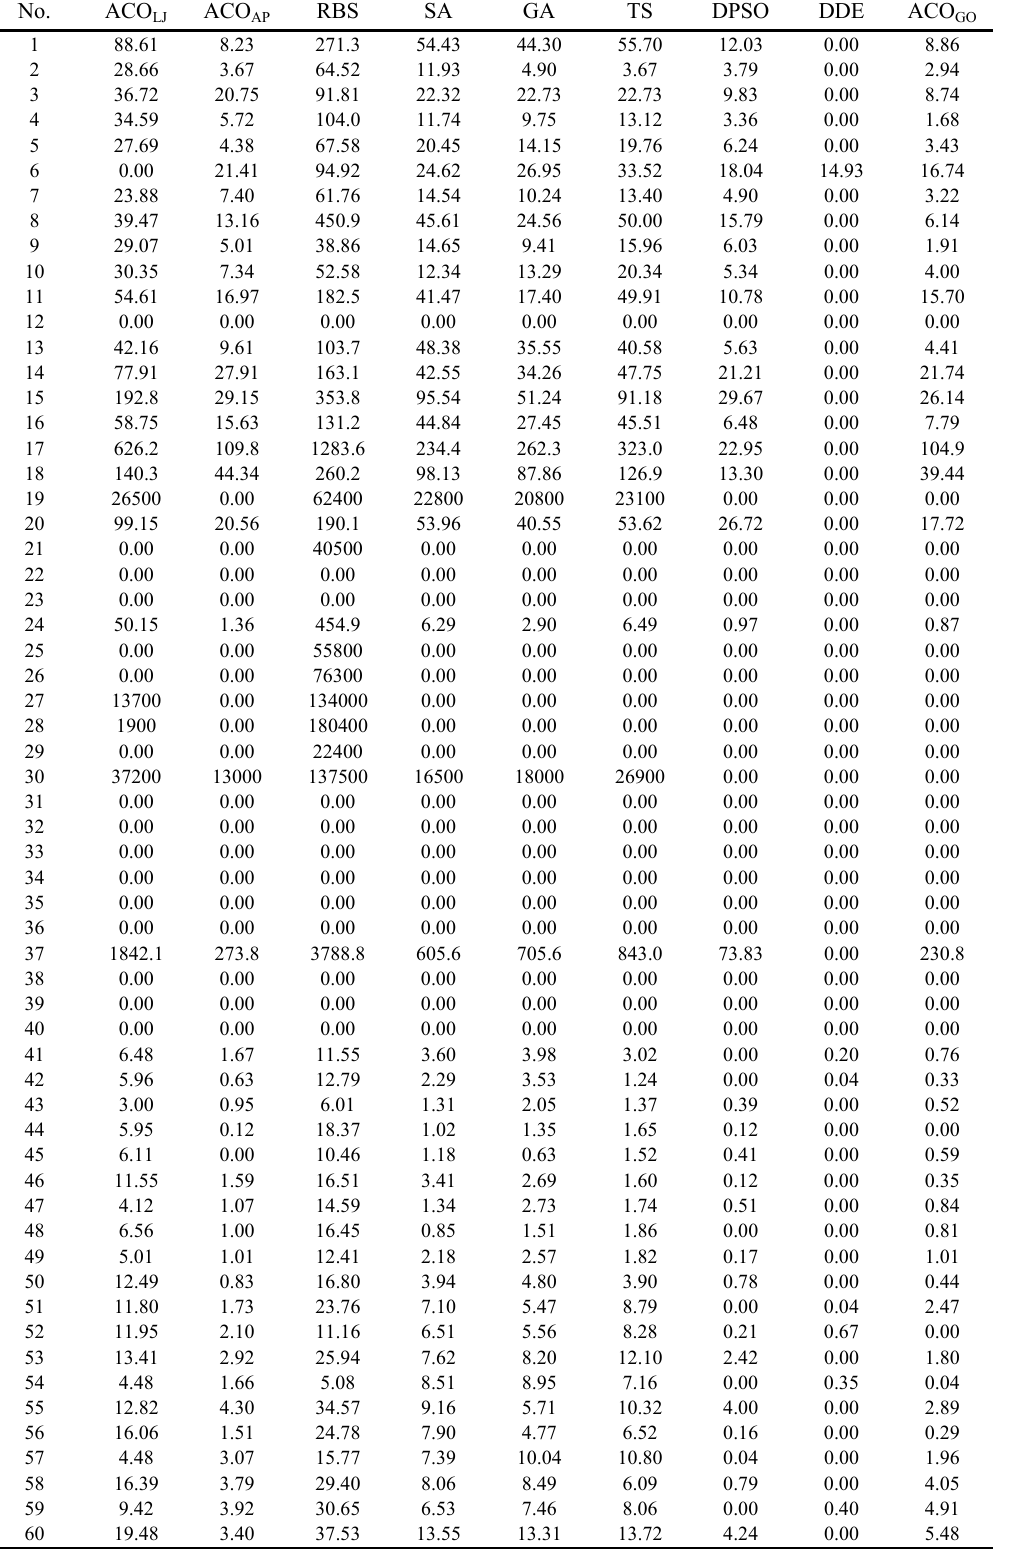
Table 2. Comparison of the proposed ACO algorithm with the other